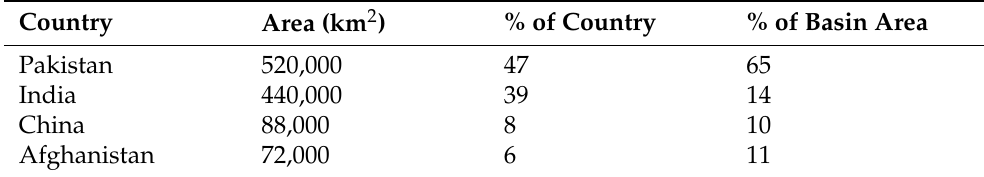
Table 1. Indus Basin Country wise (Aquastat Survey 2011).